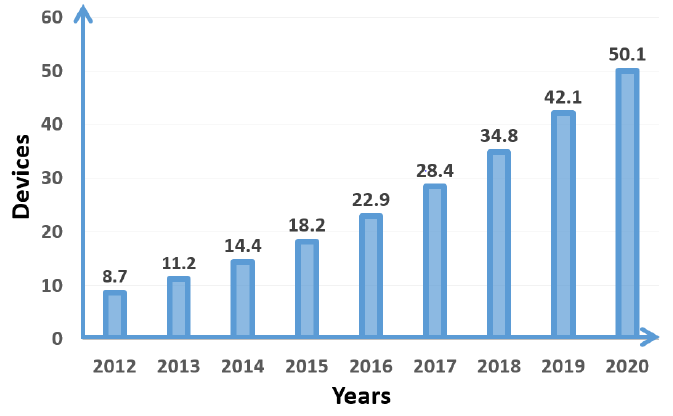
Figure 2. Number of connected IoT devices from 2012 to